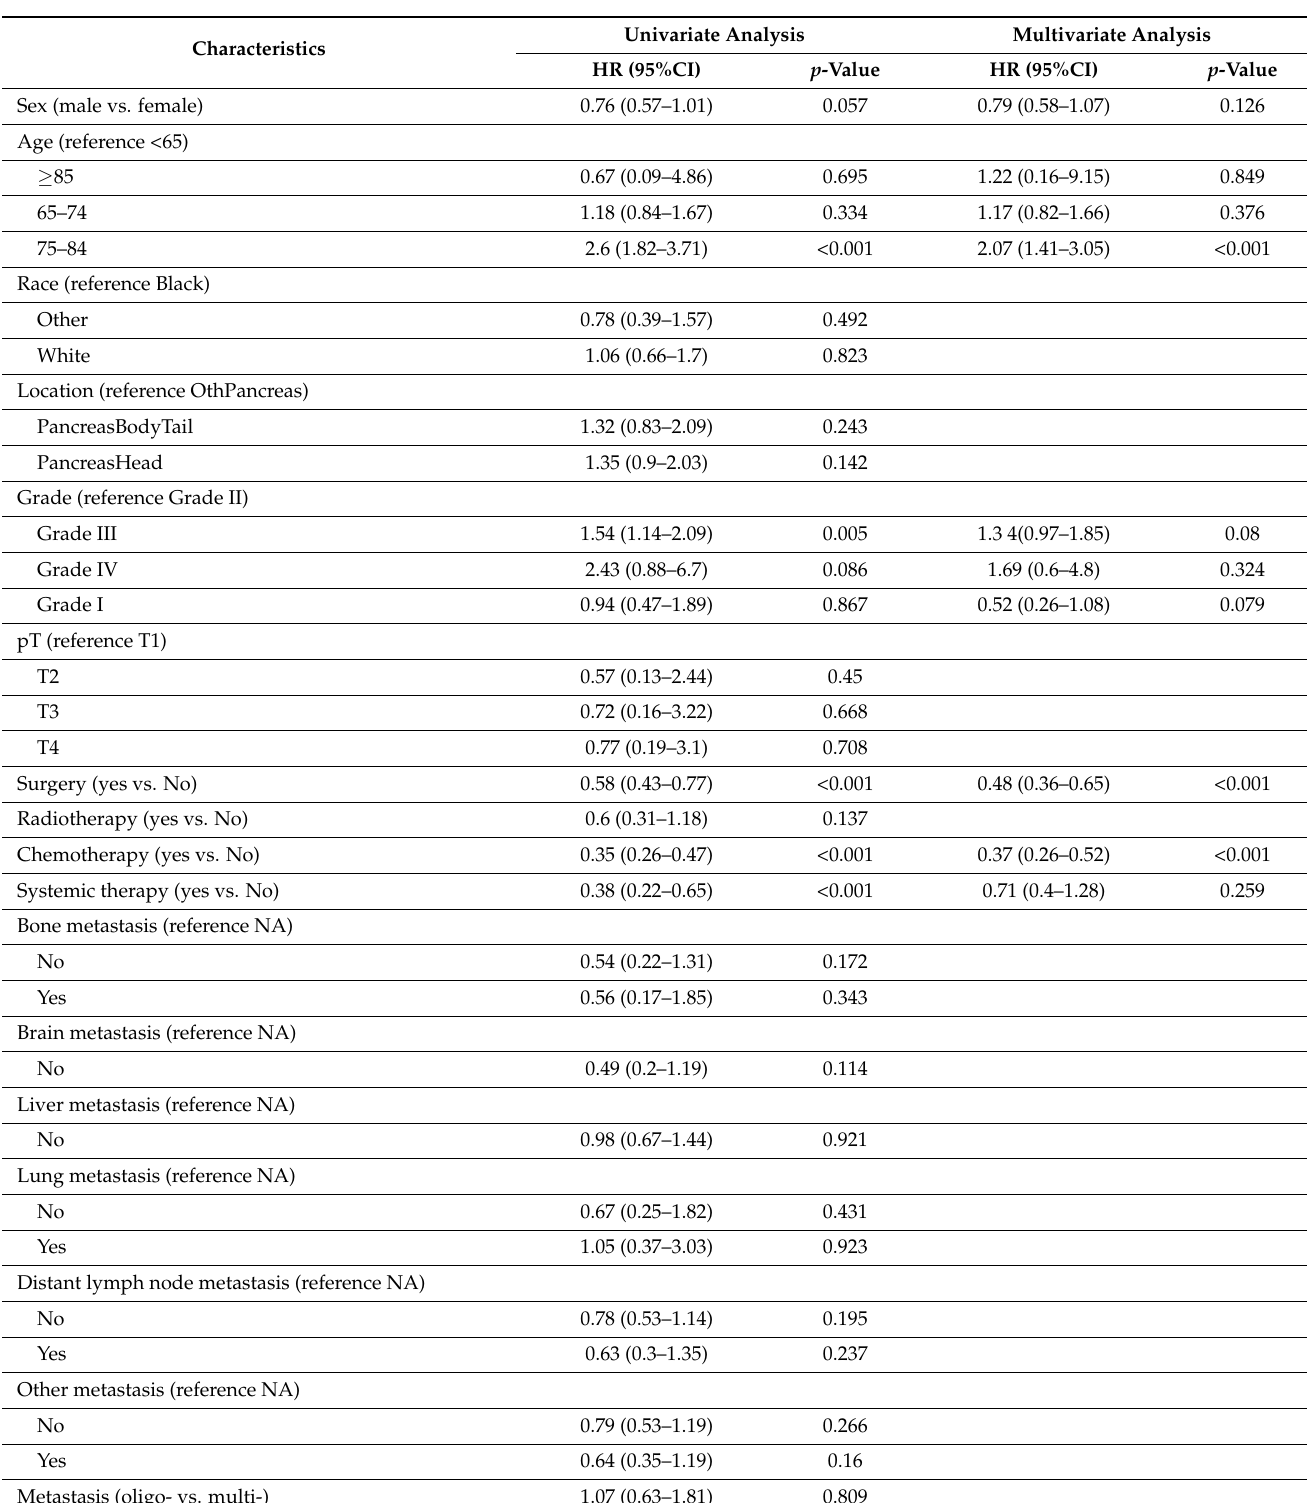
Table 3. Cox regression analysis of overall